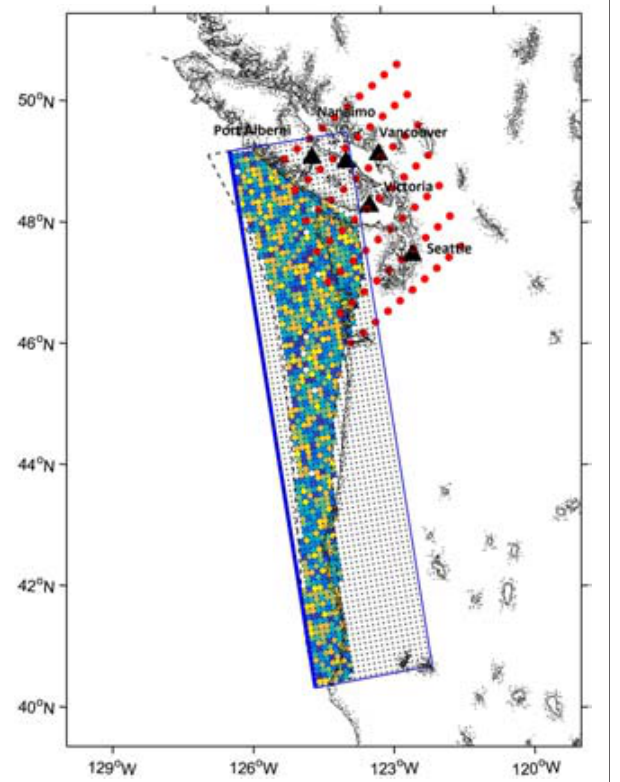
TABLE 2 | Input parameters for Cascadia-EXSIM simulations ( M